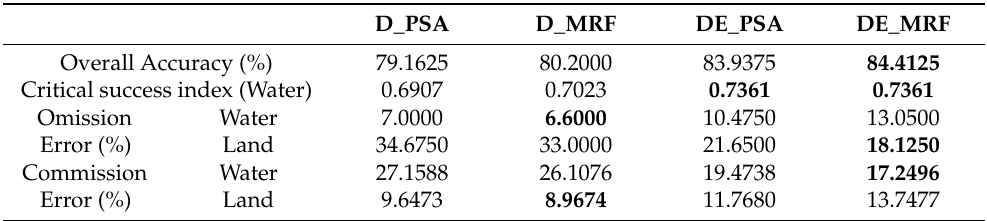
Table 3. Quantitative assessment results of different SPM methods in the mixed pixels using the 8000 sample points that are selected near the water–land boundaries highlighted with green points in Figure 5. The highest overall accuracy, highest critical success index, lowest omission, and lowest commission errors are in